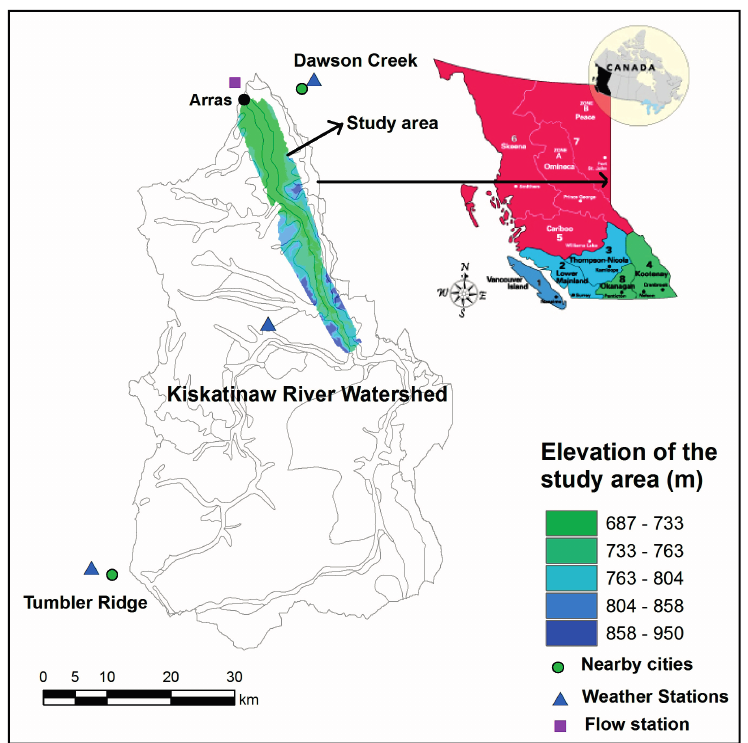
Figure 1. Digital elevation map of the study area and its location in the Kiskatinaw River Watershed as well as in the Peace Region of British Columbia, Canada. The available weather stations and flow station are also